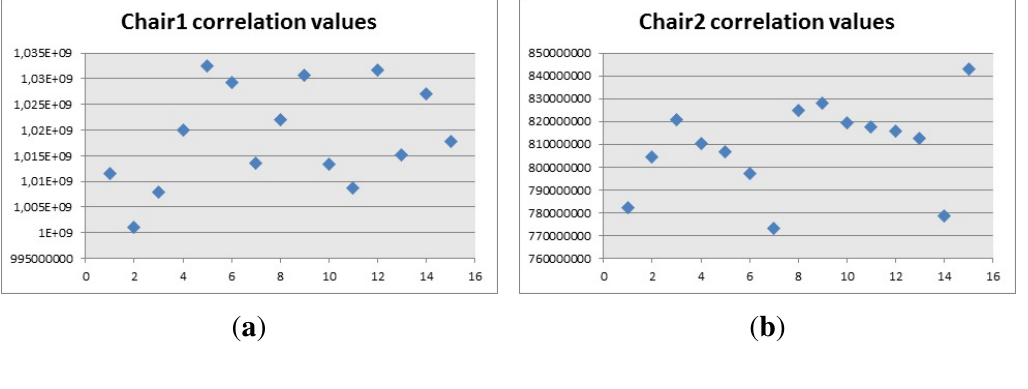
Figure 22. Correlation values,